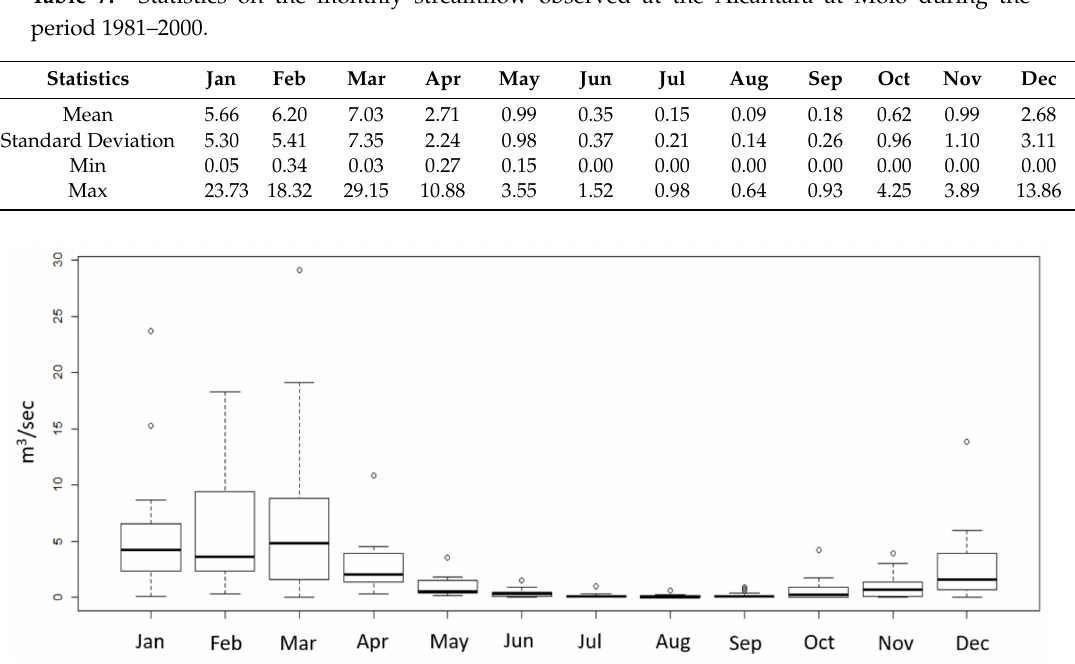
Figure 7. Variability of the streamflow data observed at Alcantara at Moio